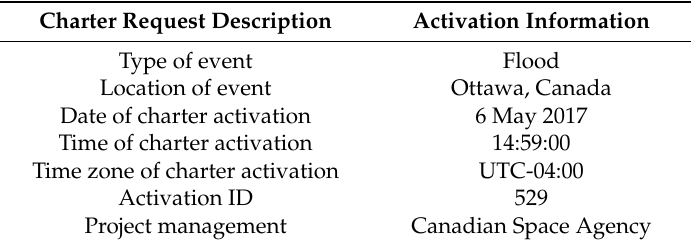
Table 1. International Charter Space and Major Disasters activation for Ottawa flood event.